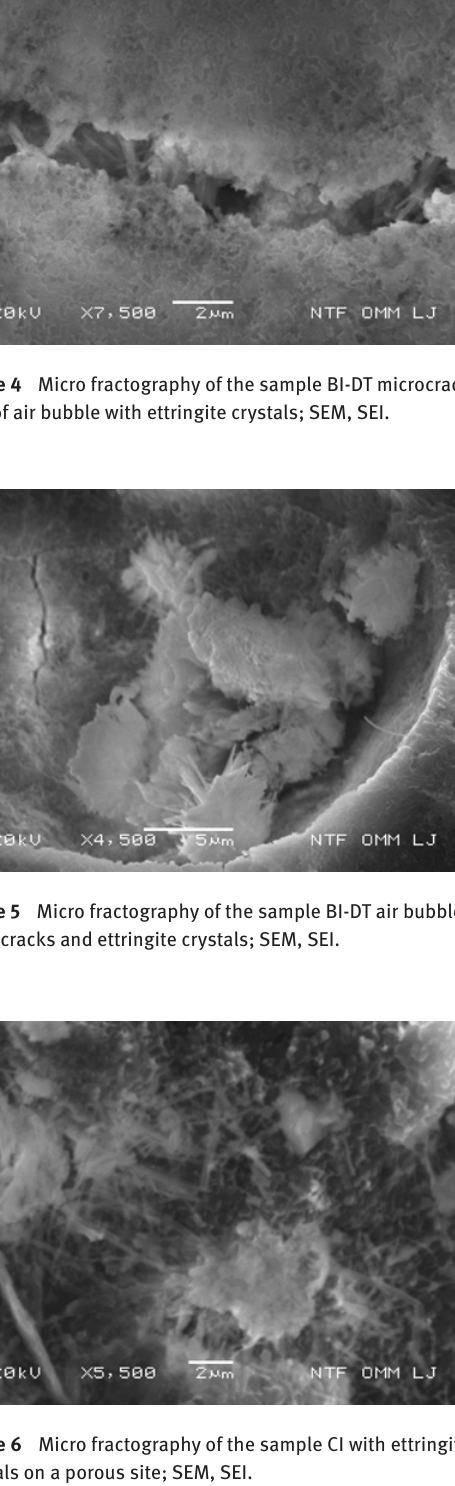
Figure 6 Micro fractography of the sample CI with ettringite crystals on a porous site; SEM,